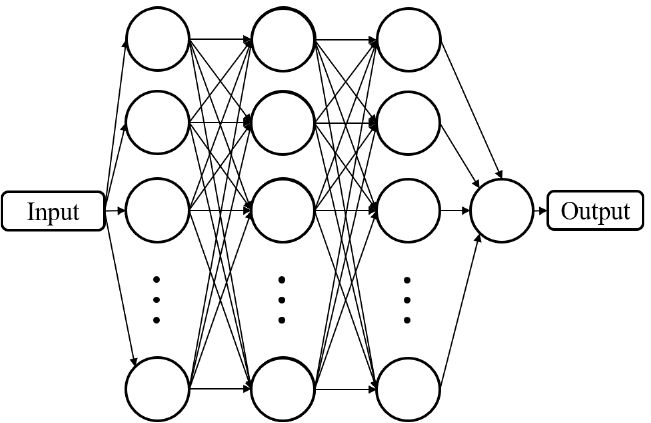
Figure 2. General topology of a multilayer fully connected neural network (reprinted with permission from ref. [23]. 2022, IEEE